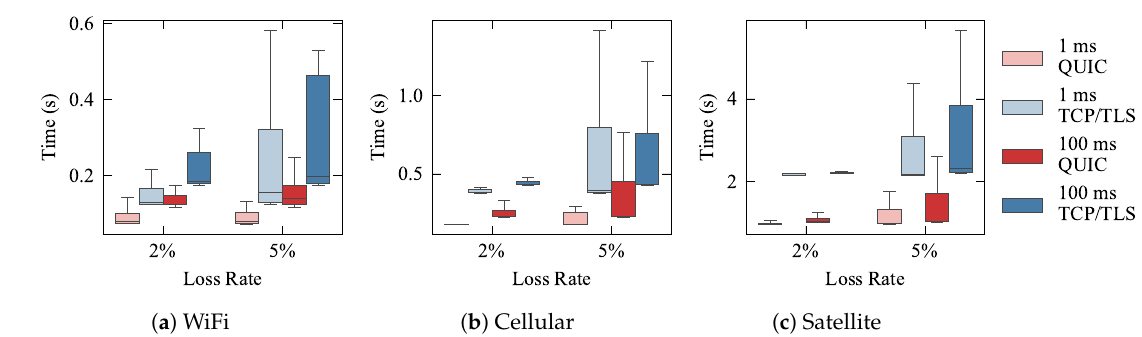
Figure 9. The publisher–broker network was fixed with the parameters of Table 1 and the broker–subscriber link with BW = 10 Gbps and RTT = 100